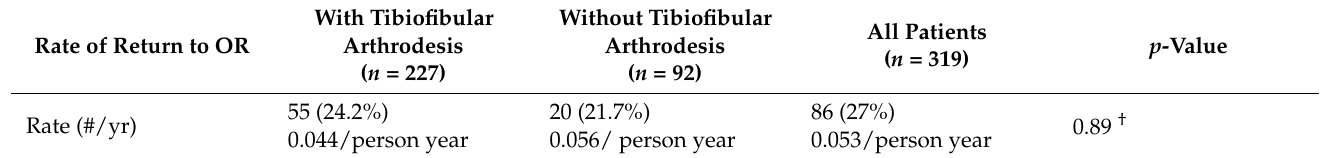
Table 8. Rate of return to OR by procedure type excluding planned removal of external fixation.